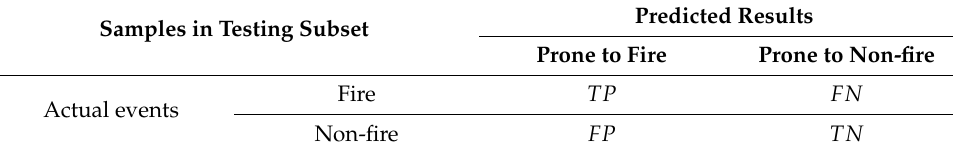
Table 5. Definition of confusion matrix.